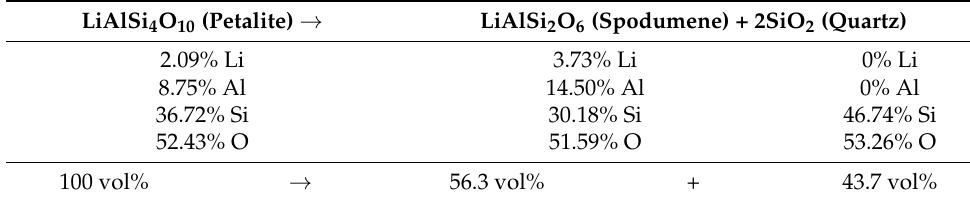
Table 6. Breakdown of petalite into spodumene and quartz intergrowth